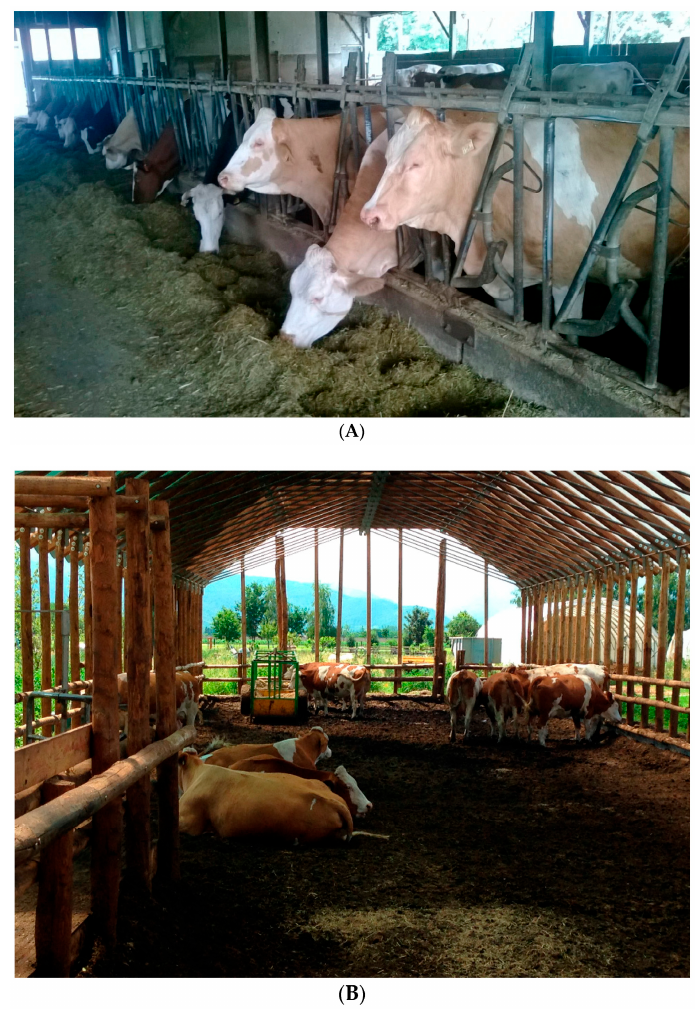
Figure 1. Pictures of the ( A ) freestall barn (FB) and the ( B ) compost barn (CB) housing